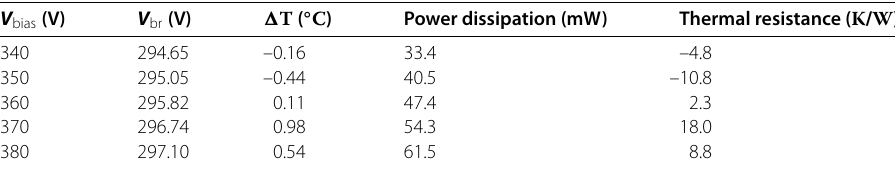
Table 2 Measurement of thermal resistance between APD and cold plate V bias (V) V br (V) (cid:2) T ( ◦ C ) Power dissipation (mW) Thermal resistance ( K / W ) 340 294.65 –0.16 33.4 –4.8 350 295.05 –0.44 –10.8 360 295.82 0.11 47.4